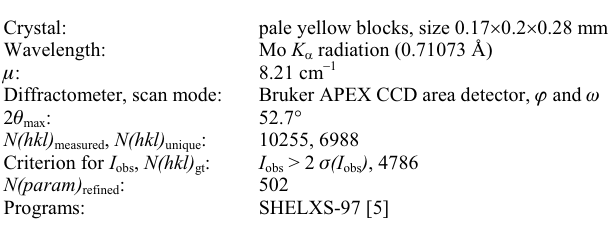
Table 1. Data collection and handling.